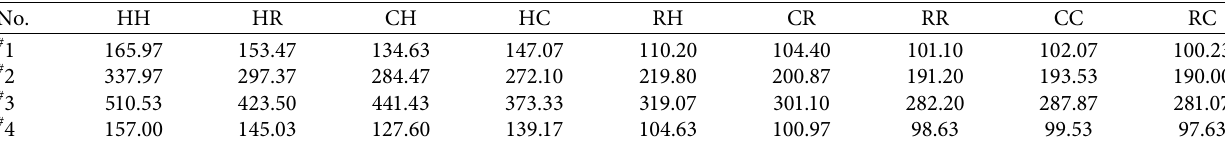
Table 8: Mean lengths of schedules returned by the LS algorithms for each of the four classes of the benchmark given in [7, 8] with cov � 90%.